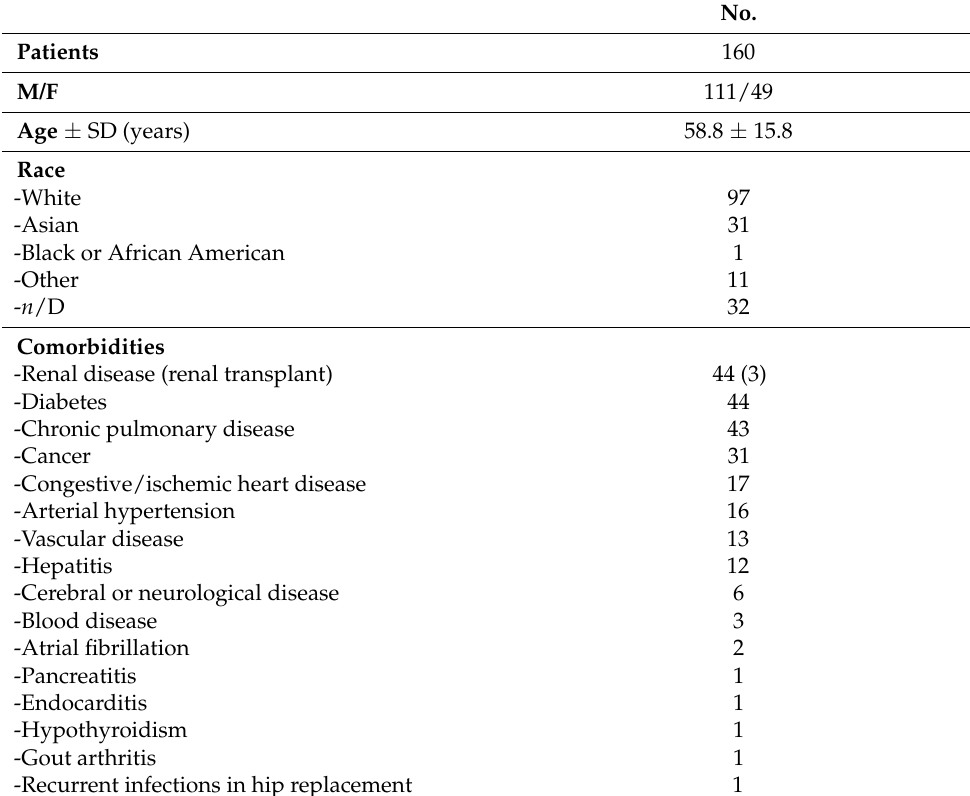
Table 3. Baseline characteristics of